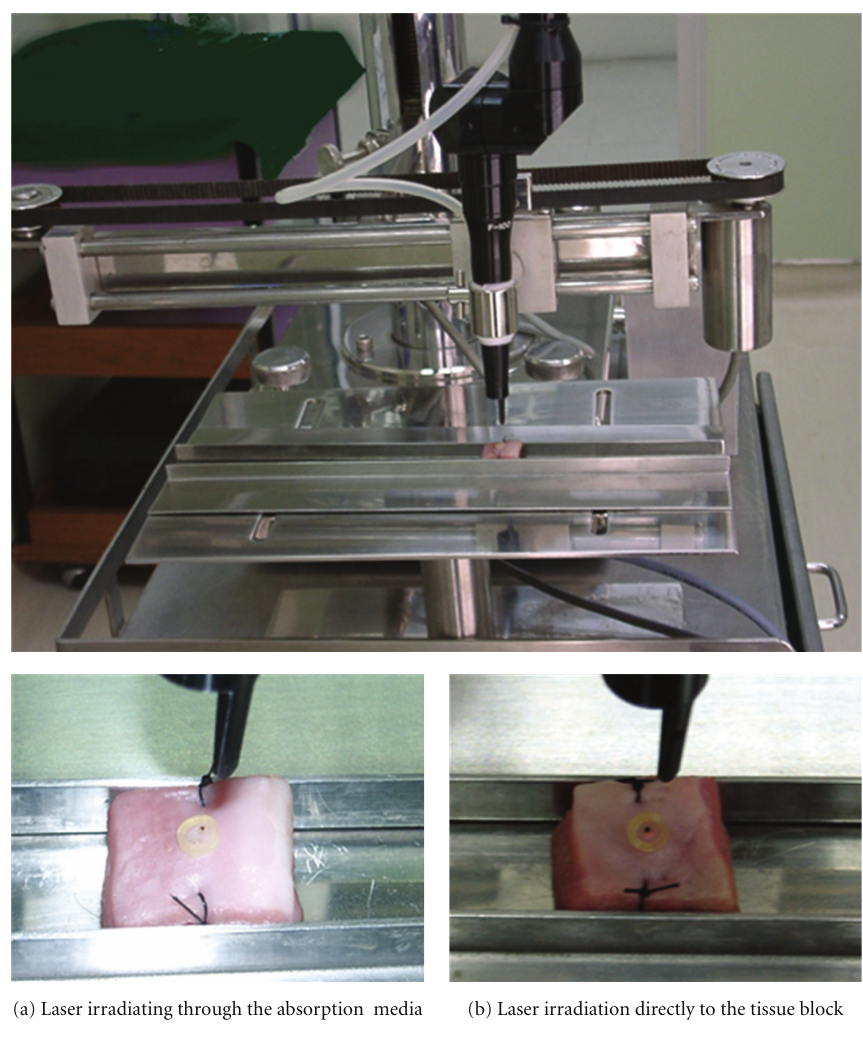
Figure 1: Laser irradiating to the samples.